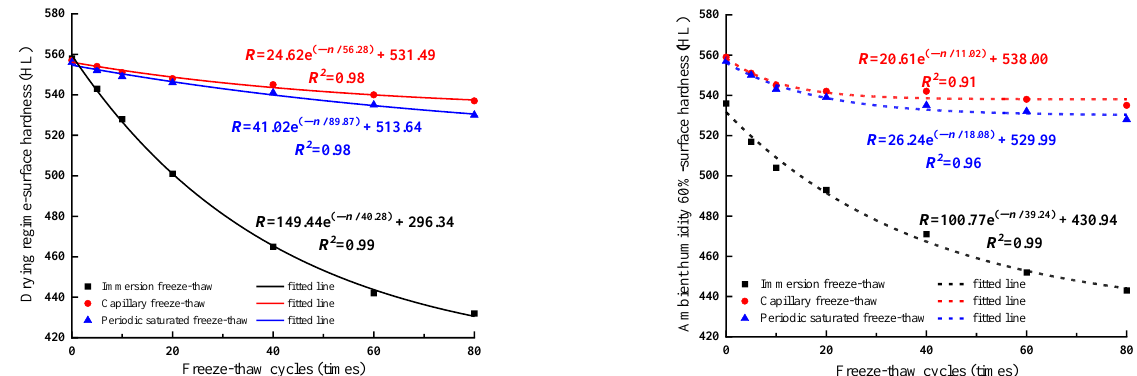
Figure 13. Surface hardness of rock samples under different test conditions.